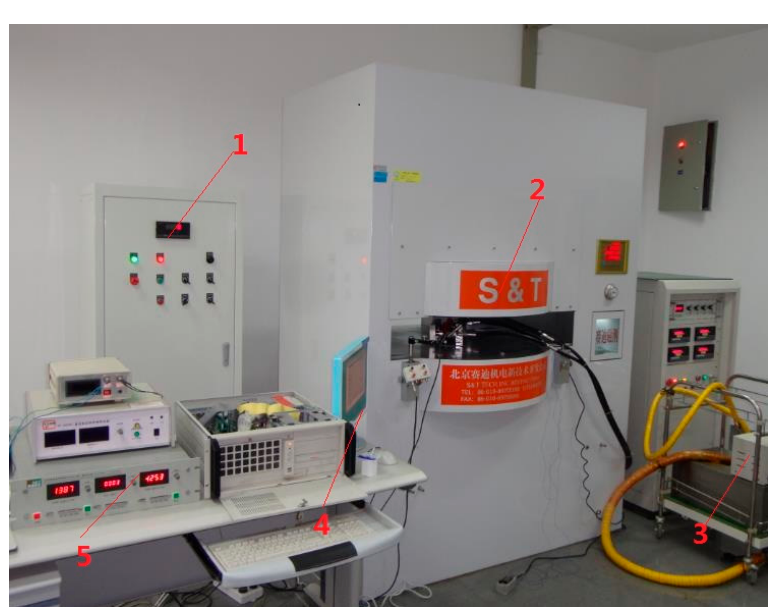
Figure 2. Experimental setup: (1) power; (2) loading device; (3) power supply for temperature loading system; (4) computer with data acquisition card, which collects input magnetic field intensity H and output magnetic induction intensity B ; and (5) control device for magnetic field.